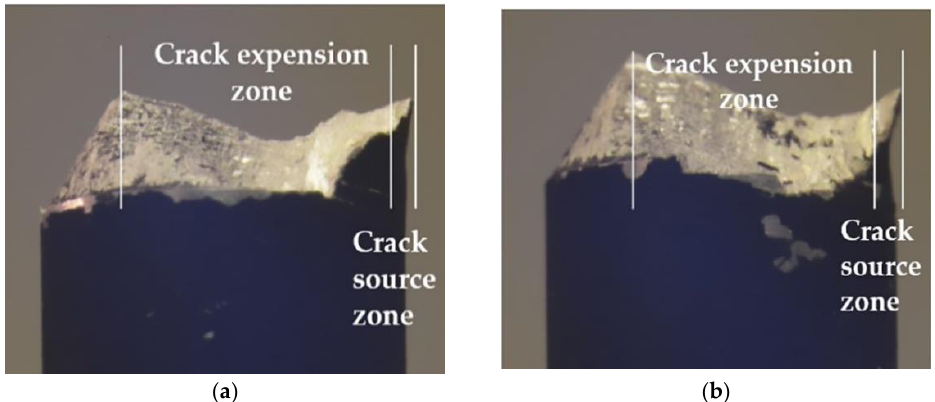
Figure 20. Section morphology of 6063-aluminum alloy samples with different powers ( a ) The second set of test pieces, test power = 40%; ( b ) the seventh set of test pieces, test power = 55%.